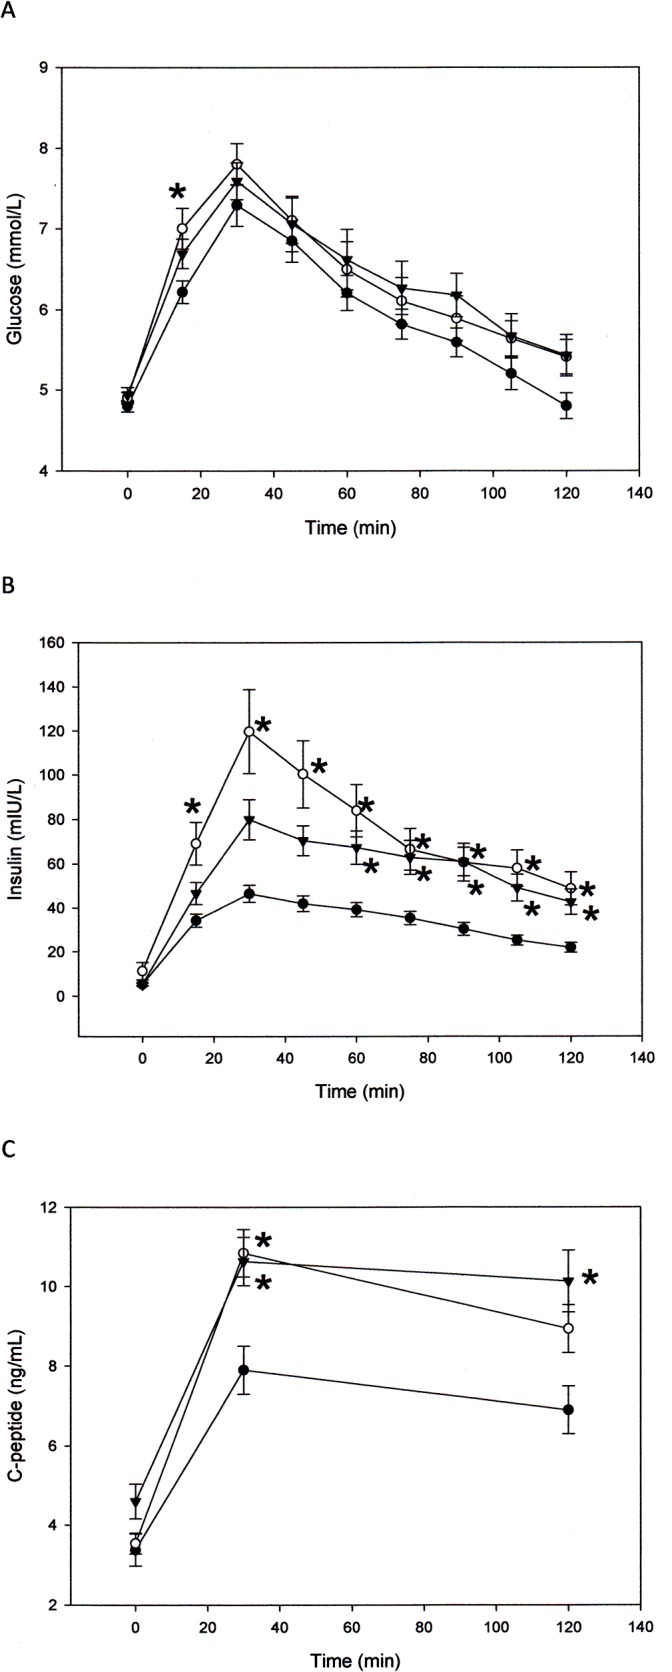
Plasma glucose (A), insulin (B) and C-peptide (C) at baseline and for 2 hrs following an oral glucose challenge in (●) C, (○) SA and (▼) SEA.Data is mean ± standard error of the mean (SEM). * is significantly different from C at same given time point. P≤.05, ANOVA, Tukey (post-hoc).